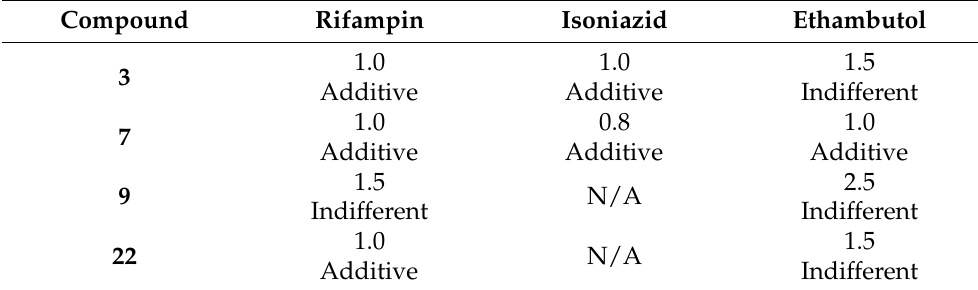
Table 7. FIC Values M. tuberculosis H37Rv for compounds 3 , 7 , 9 and 22